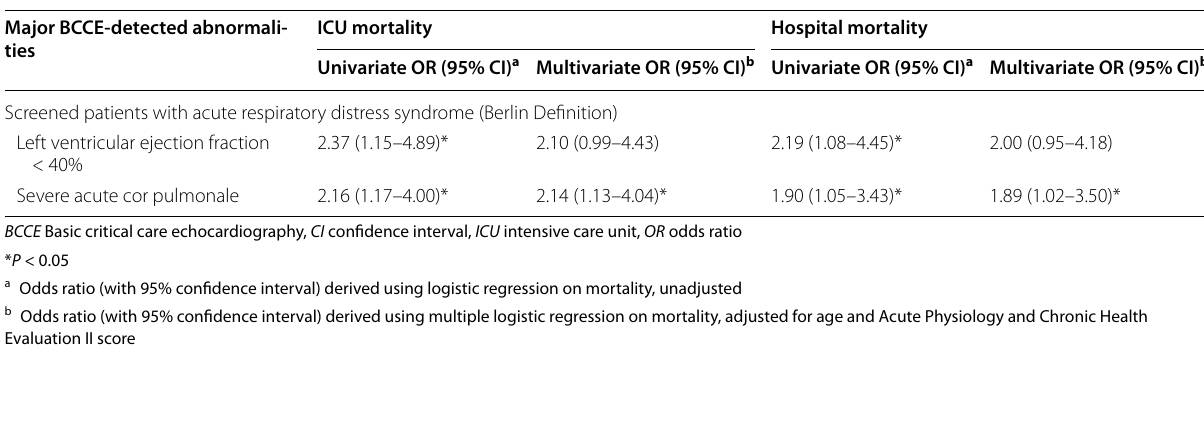
Table 3 Association of basic critical care echocardiography screening-derived abnormalities with mortality in patients with acute respiratory distress